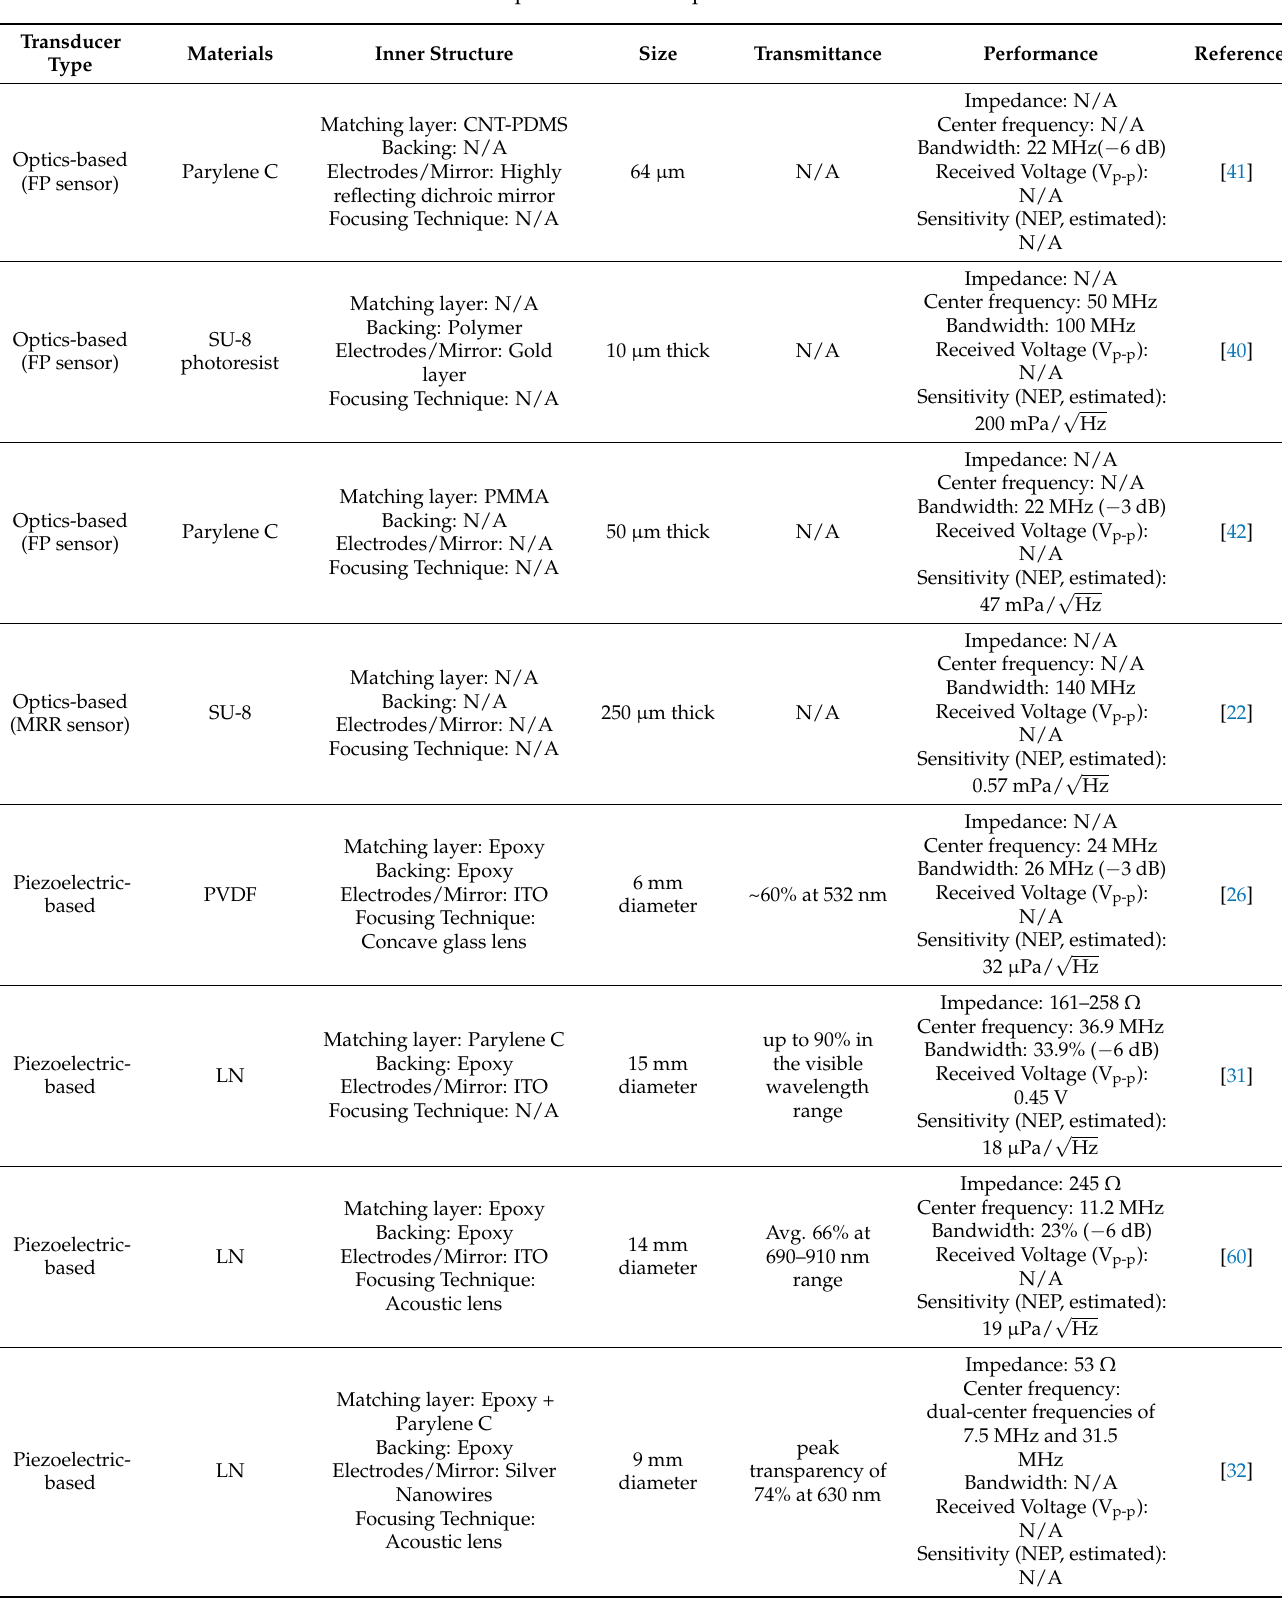
Table 2. Representative transparent US